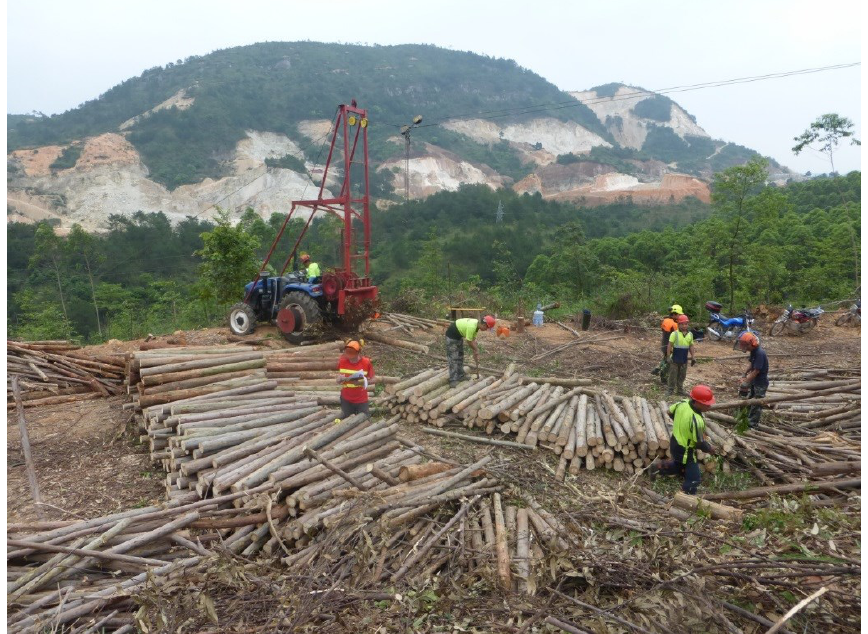
Figure 1. Semi-mechanized yarding operation applying the Igland Hauler. Stems are yarded in tree lengths (delimbed and topped) to the landing where they are crosscut by a chainsaw operator and manually sorted and stock